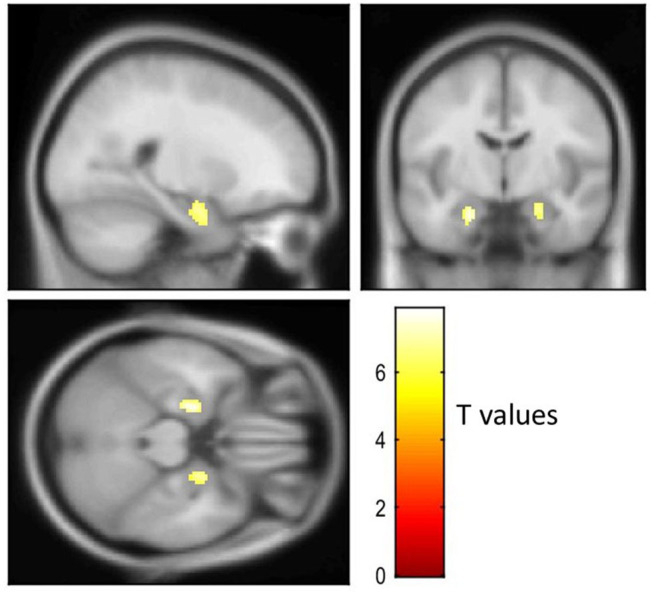
Visualization of the voxel-based [18-F]AV1451 PET tau analysis. The cluster with increased [18-F]AV1451 signal in the FTLD-AD group, compared to the FTLD-non-AD group after controlling for multiple comparisons (FEW-corrected p < 0.05; extent threshold, k = 50).